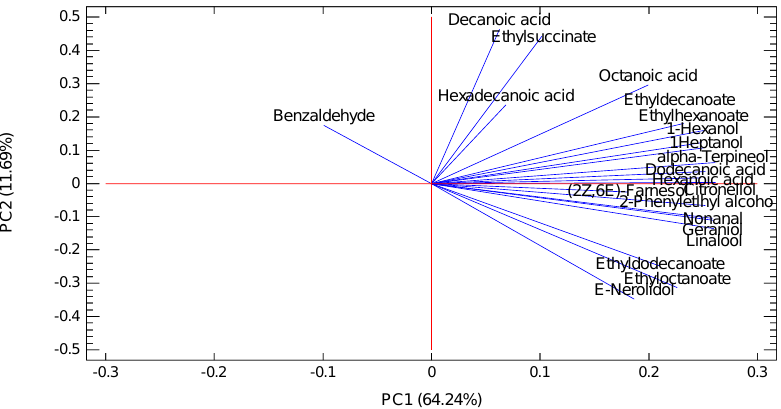
Figure 2. Factor score for four principle components of brandies.